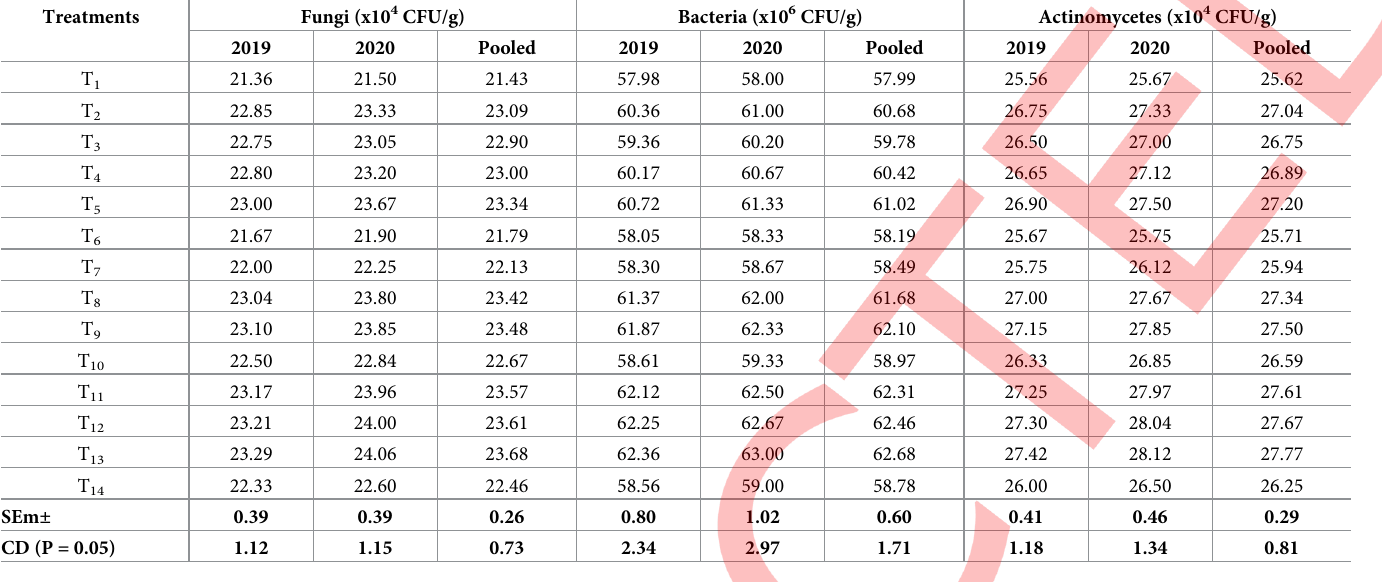
Table 2. Effect of organic manures on fungi, bacteria and actinomycetes population in per gram of soil. Treatments